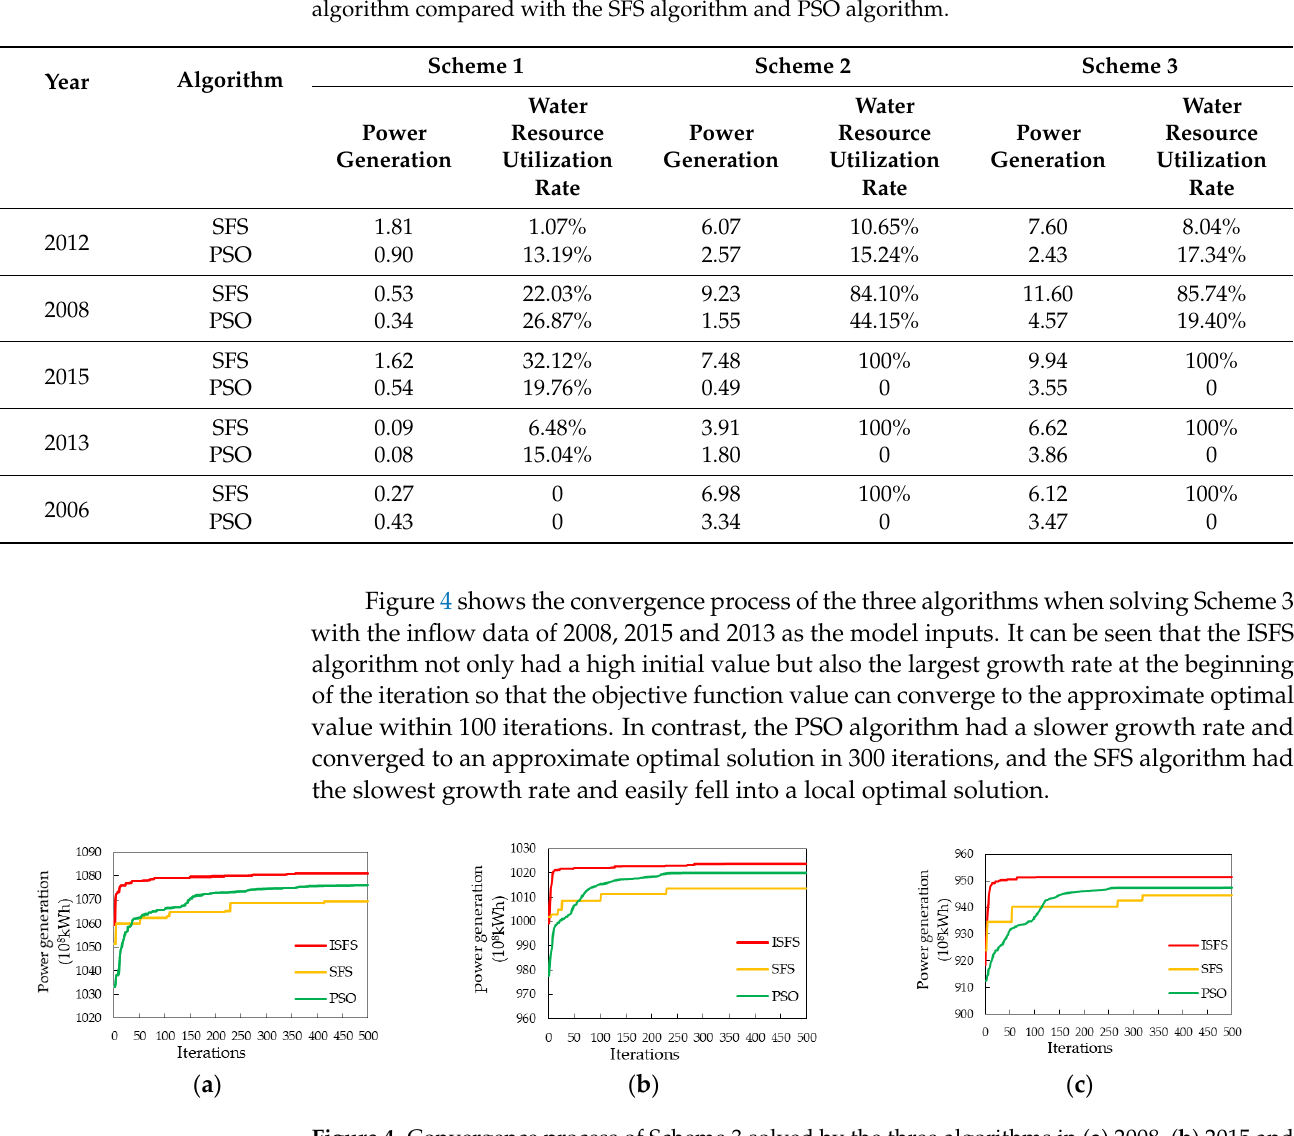
Table 3. Total power generation (10 8 kWh) and water resource utilization rate improved by the ISFS algorithm compared with the SFS algorithm and PSO algorithm.